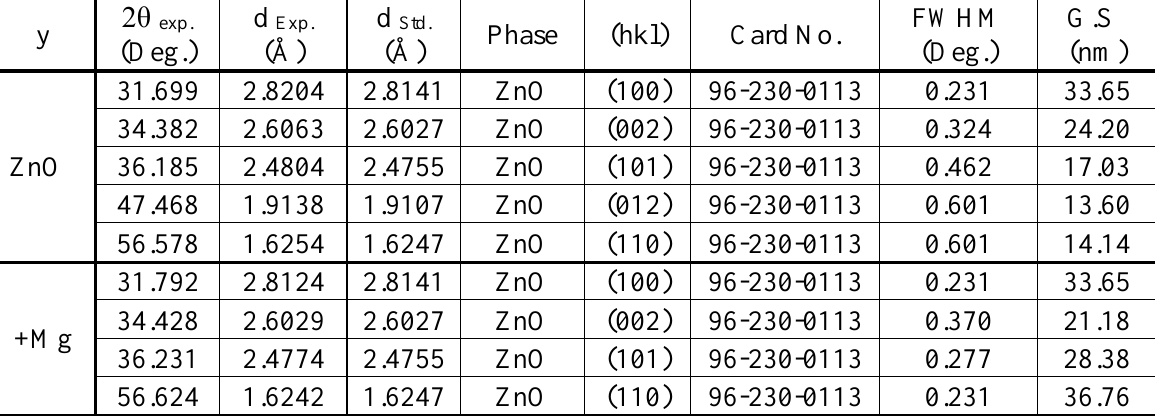
Fig.2: XRD patterns for thin ZnO pure and doped films. Table 4-1: Average crystallite size of ZnO and doped ZnO:Mg thin films and roughness of thin ZnO pure and doped